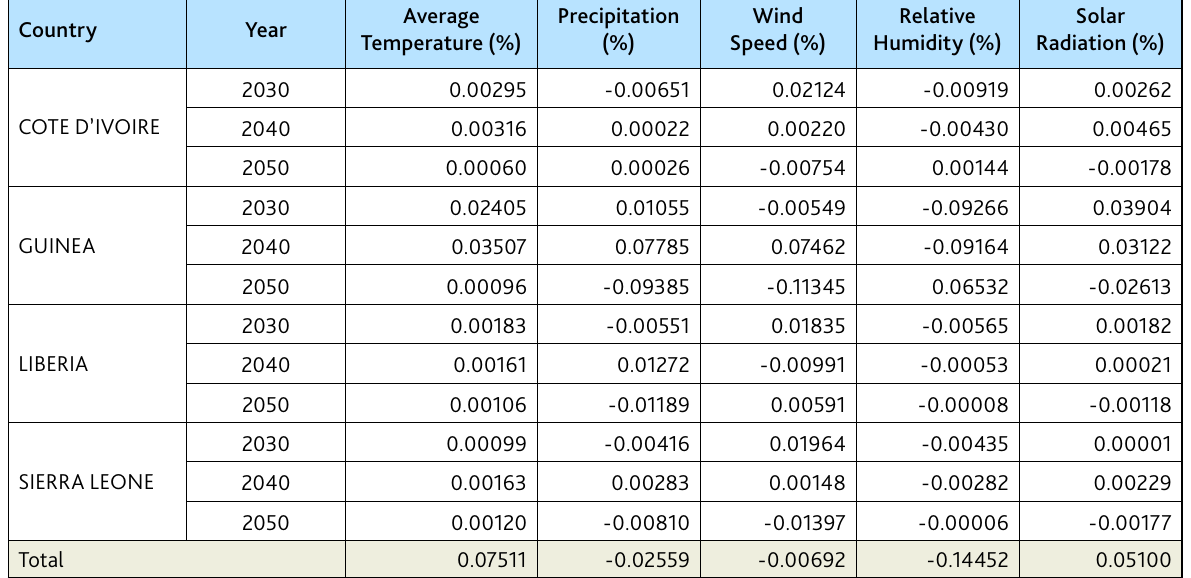
Table 5. Rate of Change of Parameters Country